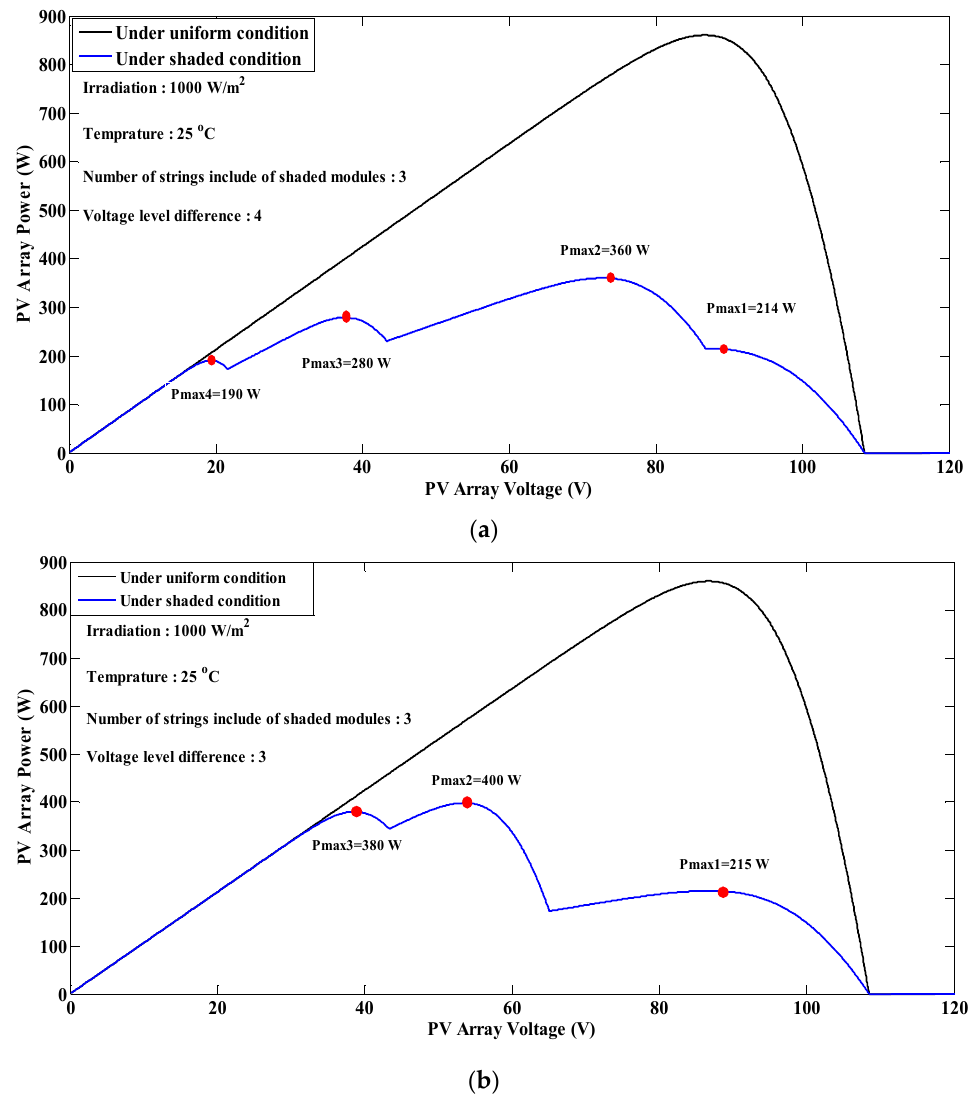
Figure 12. P ‐ V curves for different scenarios of shadowing. ( a ) first and ( b ) second scenarios.